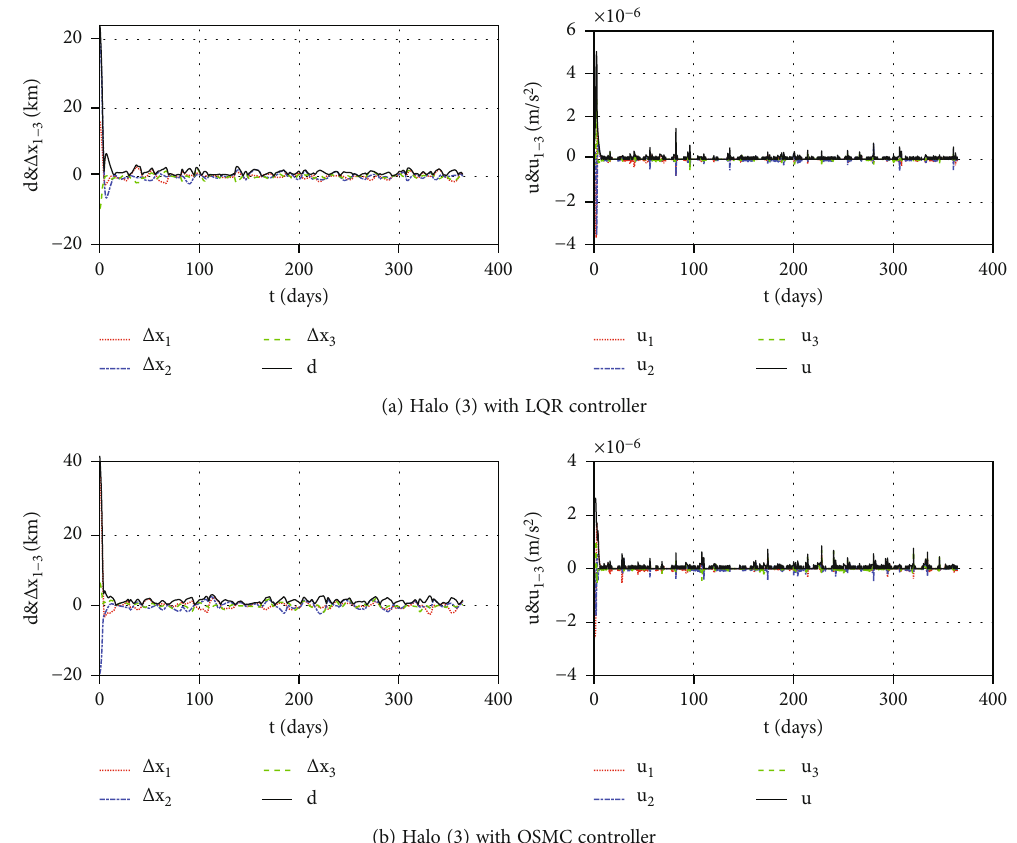
Figure 10: The station-keeping simulations of the halo (3) orbit under practical